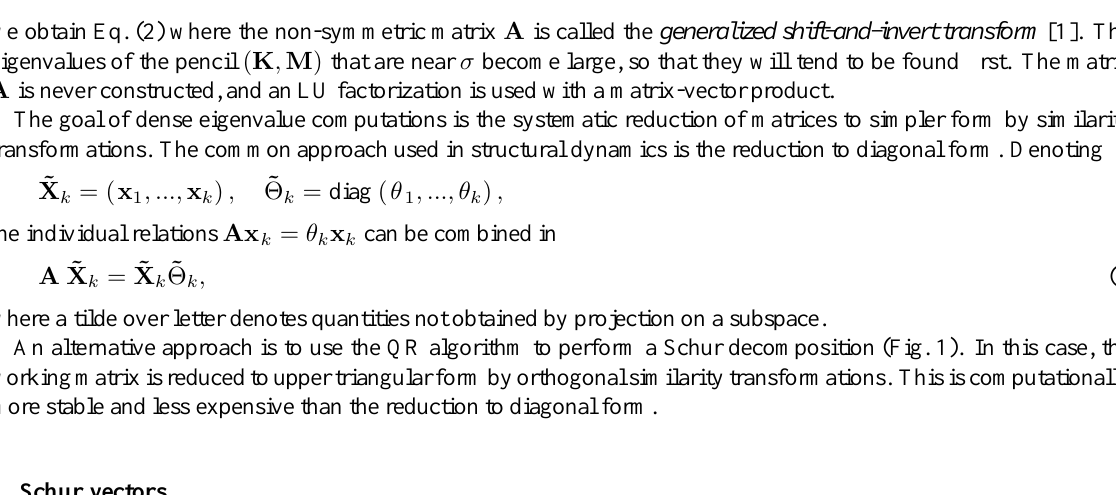
Fig. 1. Schematic of eigensolution using Schur